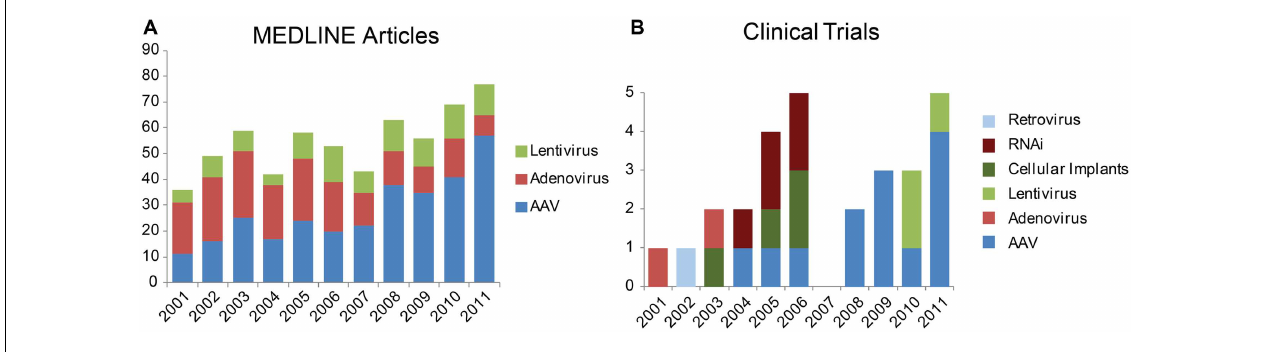
from the database GeneTherapy ClinicalTrials Online from the Journal of Gene Medicine. Results restricted to “ocular diseases” and sorted by date approved.